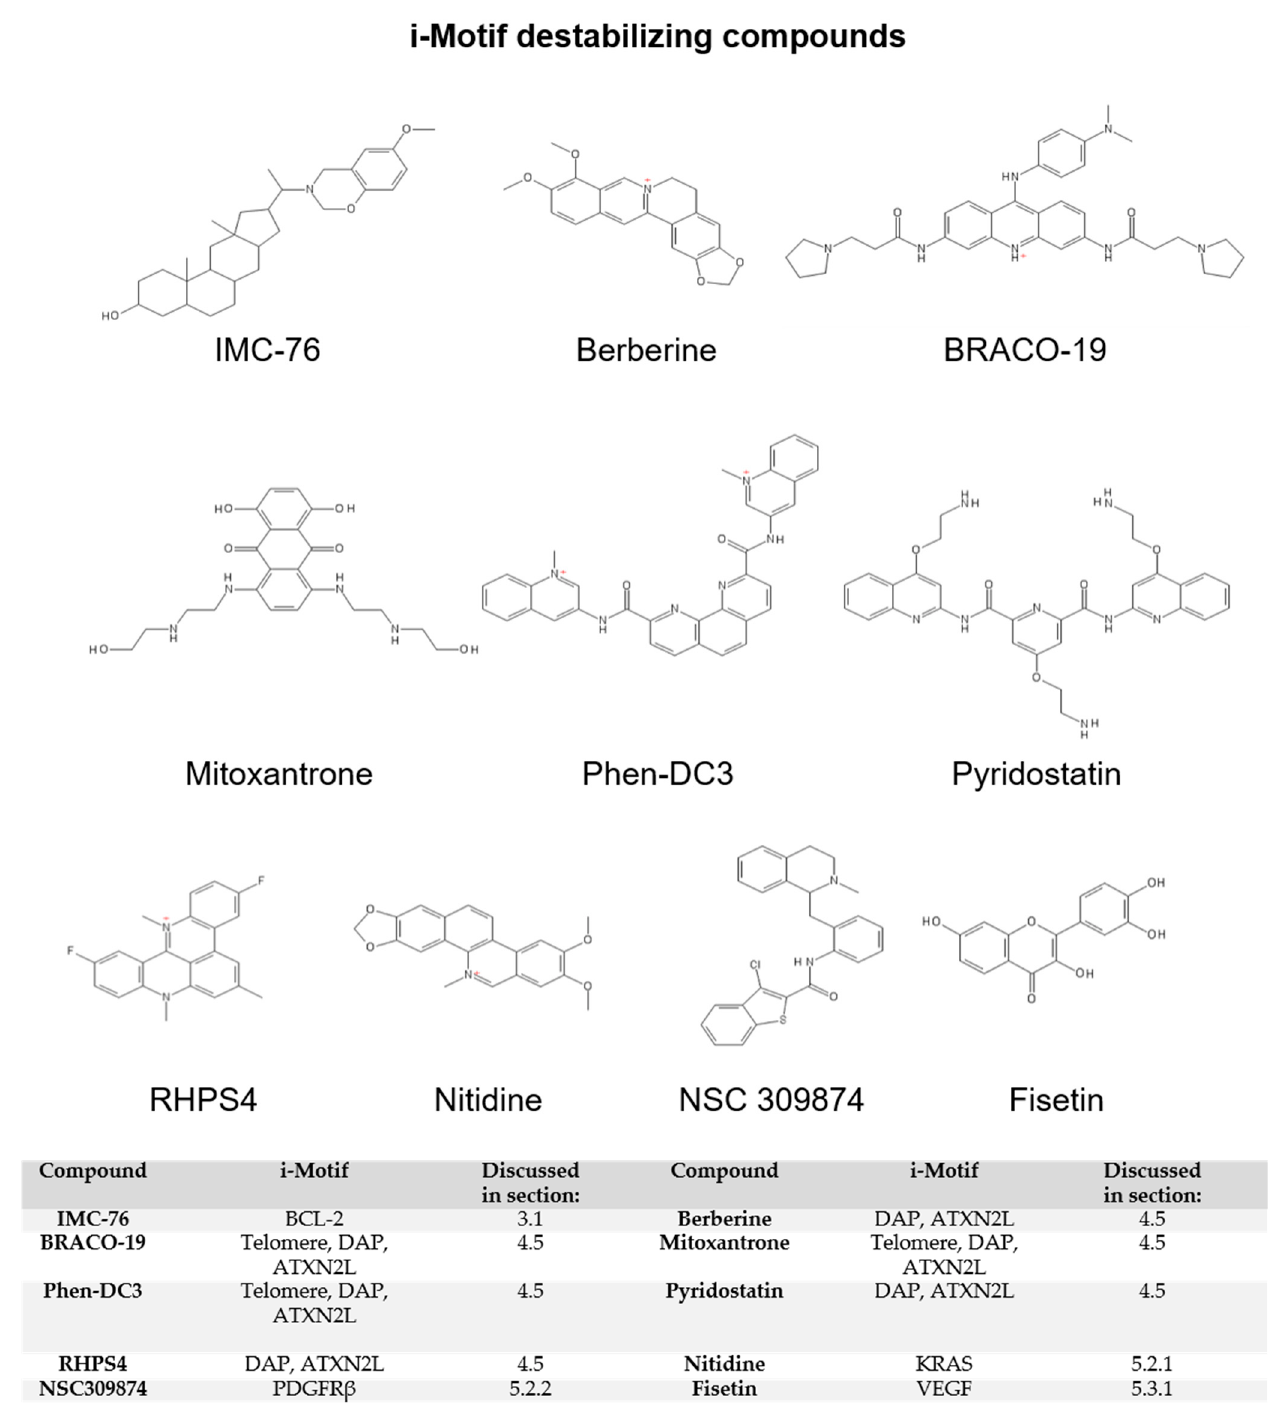
Figure 4. i-Motif destabilizing compounds.